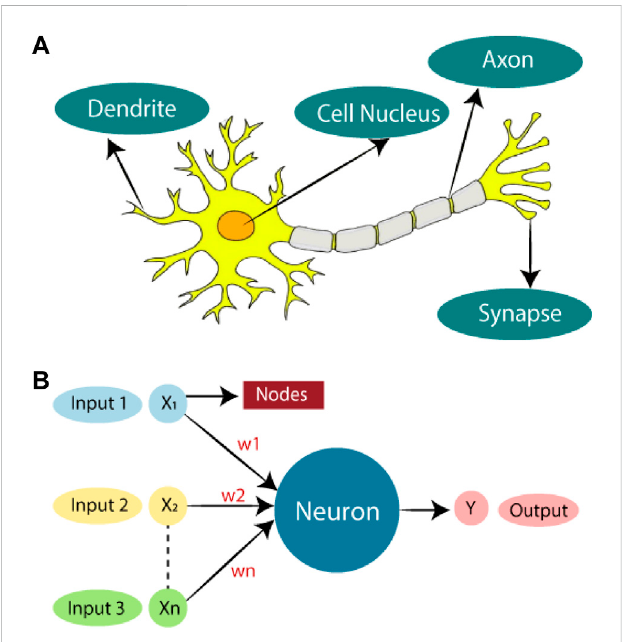
FIGURE 8 (A) Biological neural network (B) arti fi cial neural network. Adapted from (Javapoint, 2021).